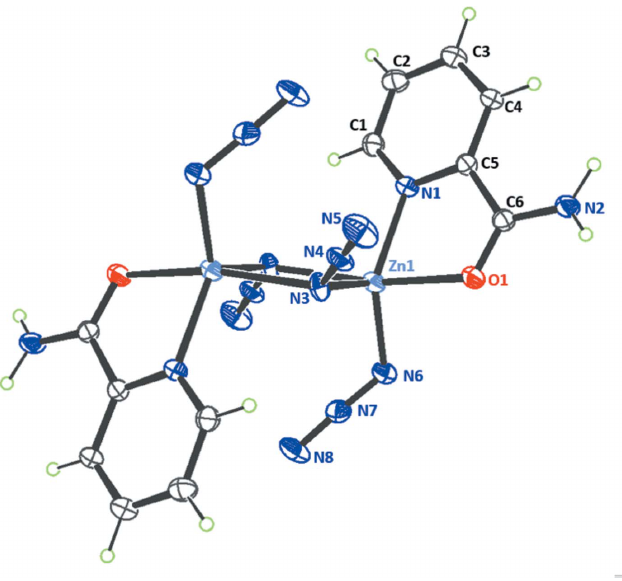
Figure 1 Molecular structure of the title compound, showing 50% probability displacement ellipsoids for non-H atoms. Non-labelled atoms are generated by the symmetry operation 1 (cid:2) x , 1 (cid:2) y , 1 (cid:2) z .